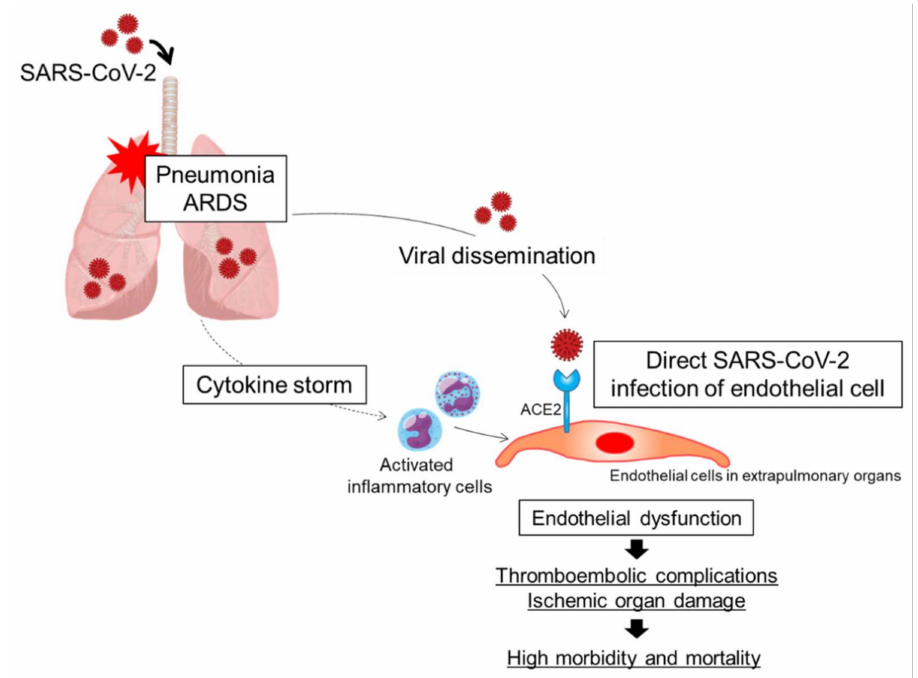
Figure 1. Putative mechanisms of endothelial dysfunction in patients with COVID-19. A combination of direct SARS-CoV-2 infection of endothelial cells and a cytokine storm originating in the lungs may synergistically cause endothelial cell injury and/or activation, leading to endothelial dysfunction. ARDS, acute respiratory distress syndrome; ACE2, angiotensin-converting enzyme